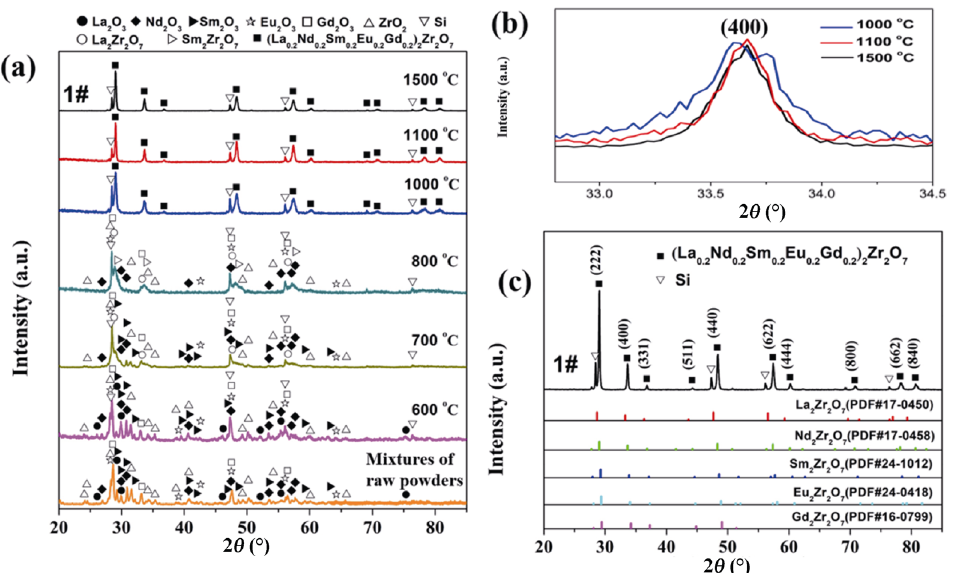
Fig. 1 (a) XRD patterns of the mixtures of raw powders (sample number 1#) and ceramic products after sintering at temperatures ranging from 600 to 1500 ℃ . (b) Zoom-in view of the (400) diffraction peaks of the ceramics sintered at 1000, 1100, and 1500 ℃ . (c) XRD patterns of ceramics 1# sintered at 1500 ℃ for 3